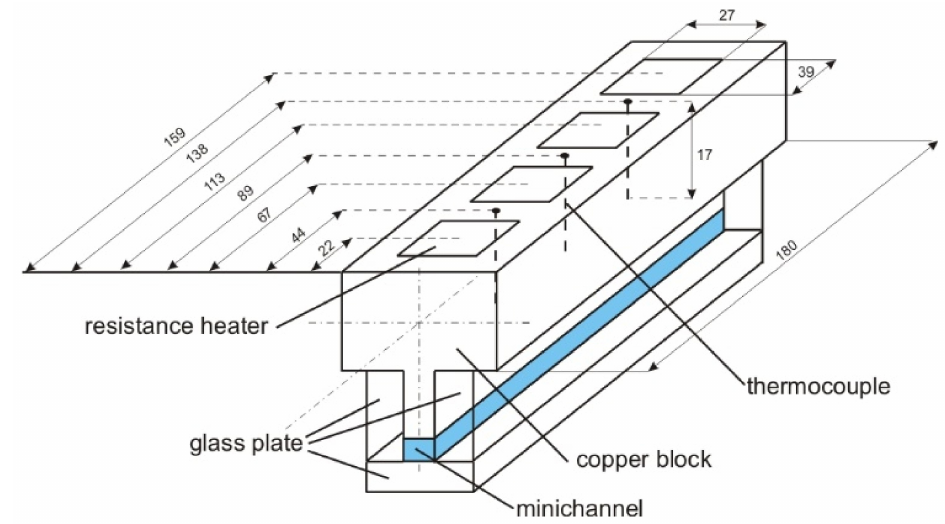
Figure 2. General view of the experimental stand; labels as in Figure 1.